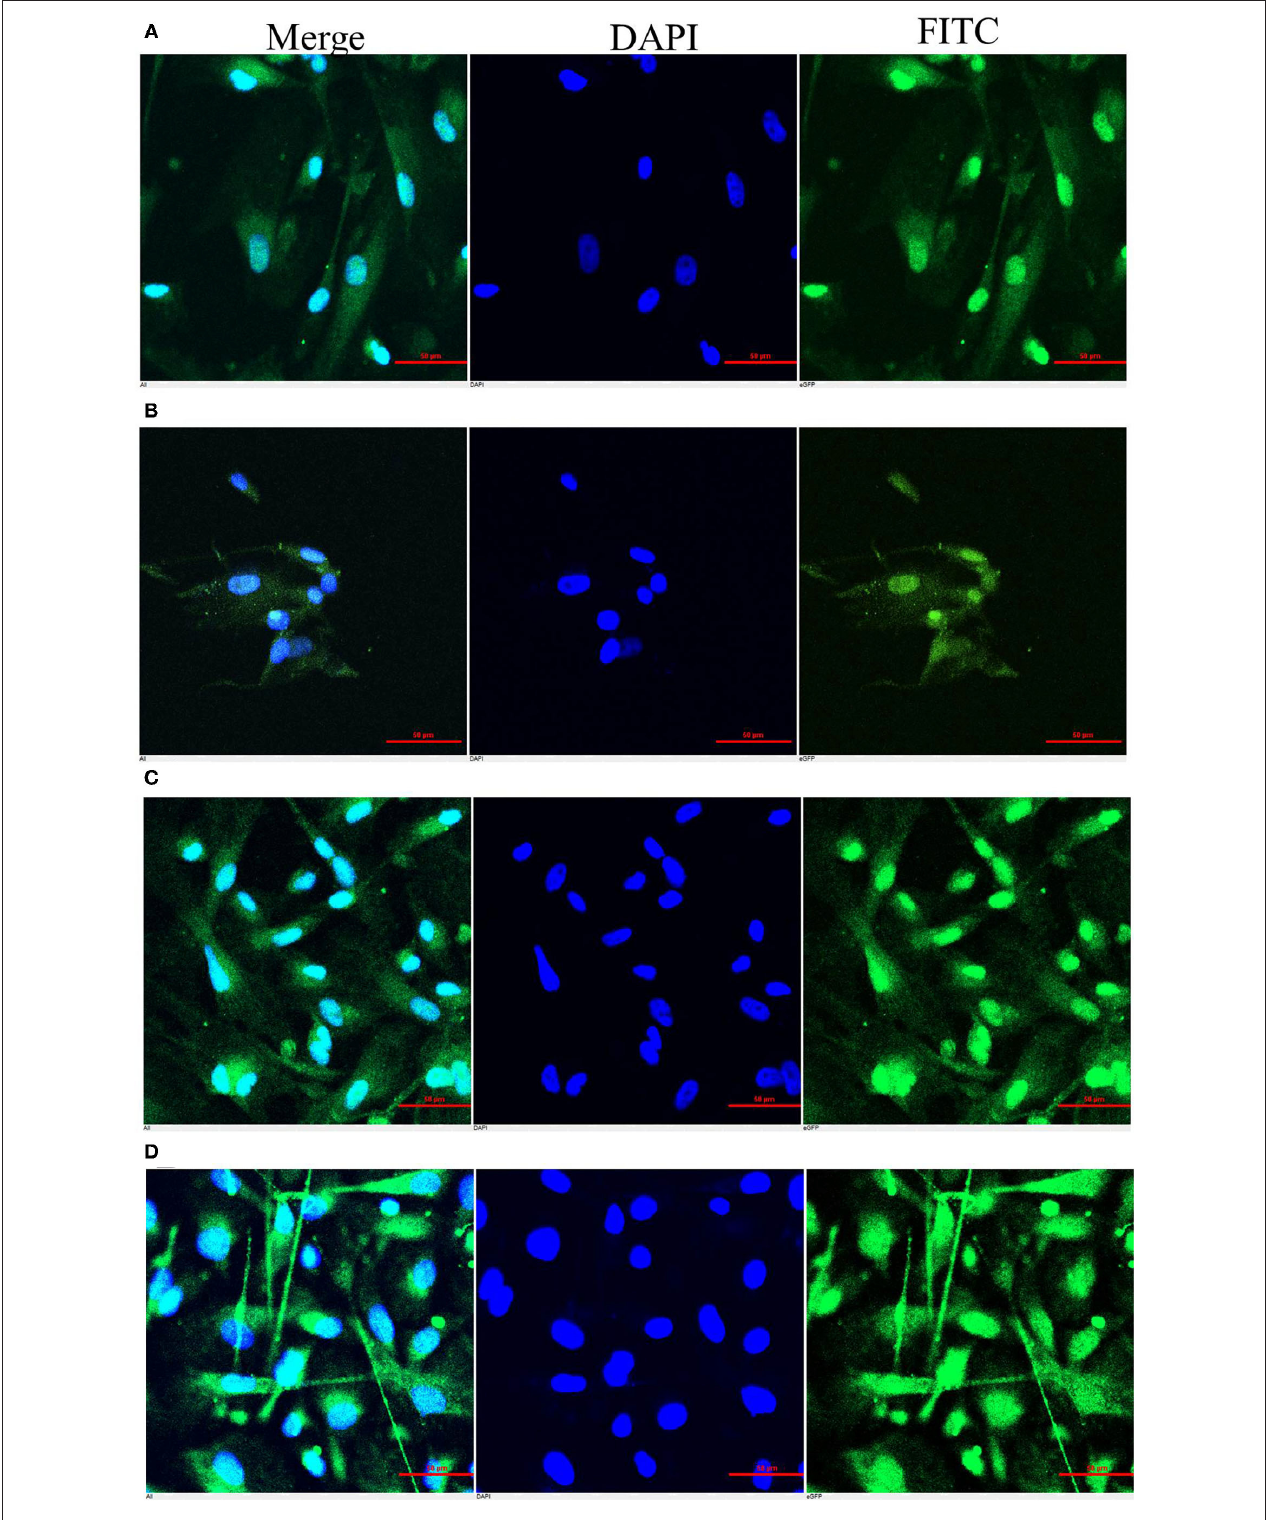
FIGURE 8 | Immunocytochemistry of the CMT-1026 cell line. The cells showed positivity for Claudin-1 (A) , Delta-catenin (B) , Sox-2 (C) , and Ki-67 (D) in the cell membrane.